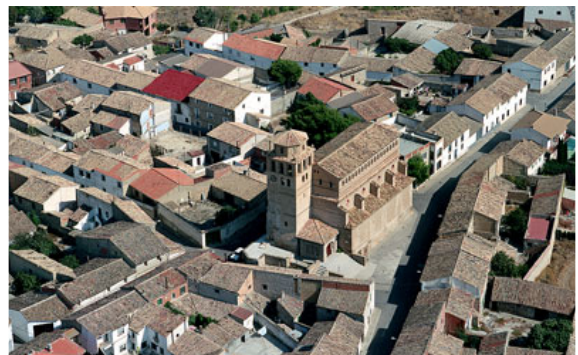
Figure 4. Aerial view of Perdiguera.